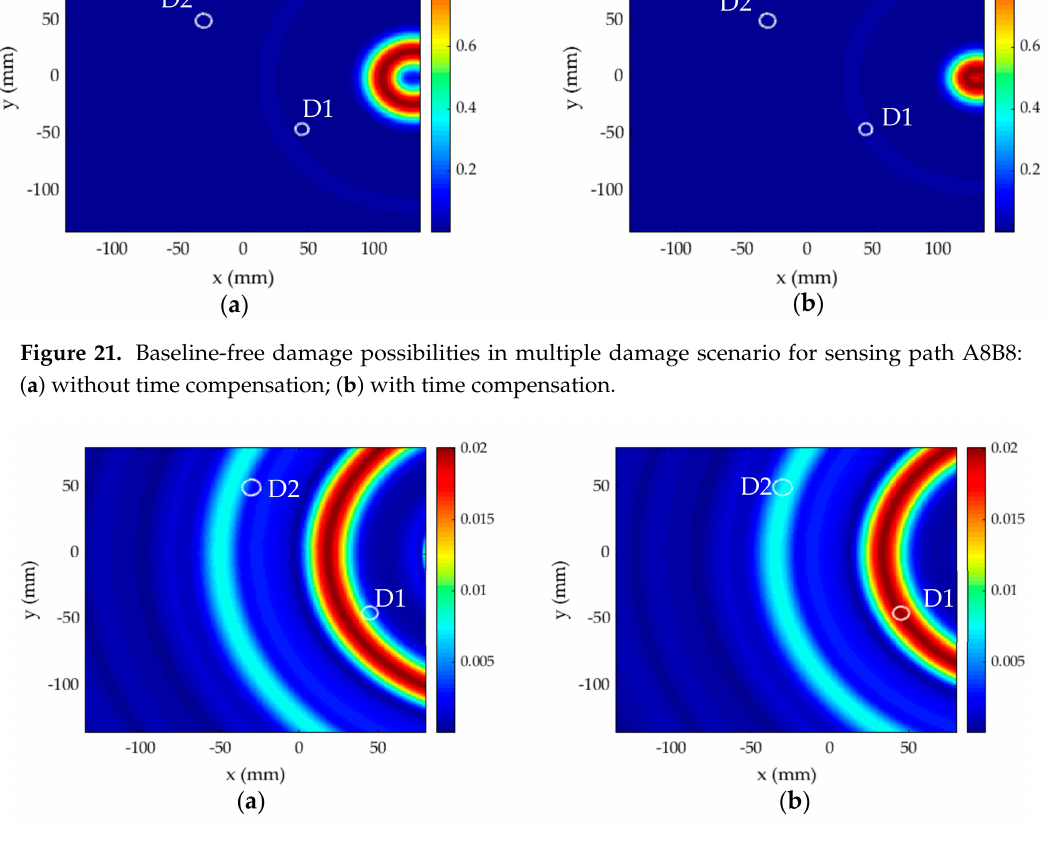
Figure 22. Damage-focused region of ( a ) Figure 21a; ( b ) Figure 21b.